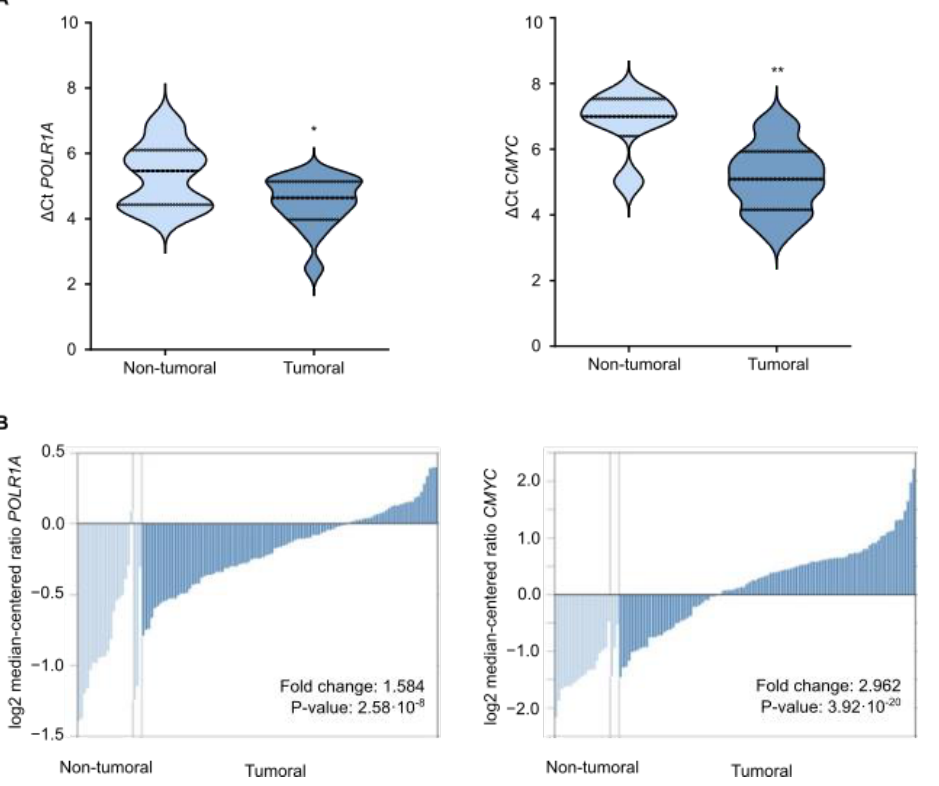
Figure 5 . Gallic acid could be explored for patients with CRC as therapy. ( A ) ΔCt results for POLR1A and CMYC obtained by qRT-PCR in the cohort of patients with CRC. ( B ) Analysis of POLR1A and CMYC expression levels in Oncomine database with “TCGA Colorectal” dataset including non- tumoral (N = 22) and tumoral (N = 101) samples. For all tests, p -values below 0.05 were considered significant and expressed as follows: * p < 0.05 and ** p <